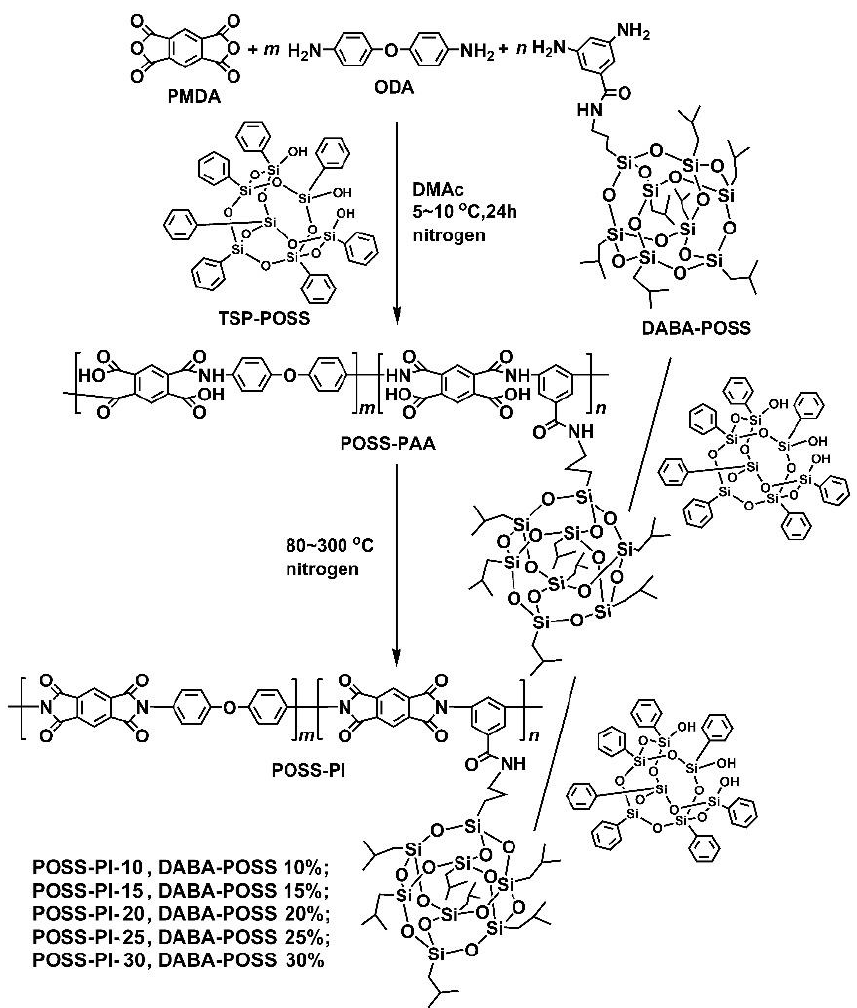
Figure 2. Synthesis of POSS-poly(amic acid) (PAA) varnishes and the derived POSS-polyimide (PI) composite